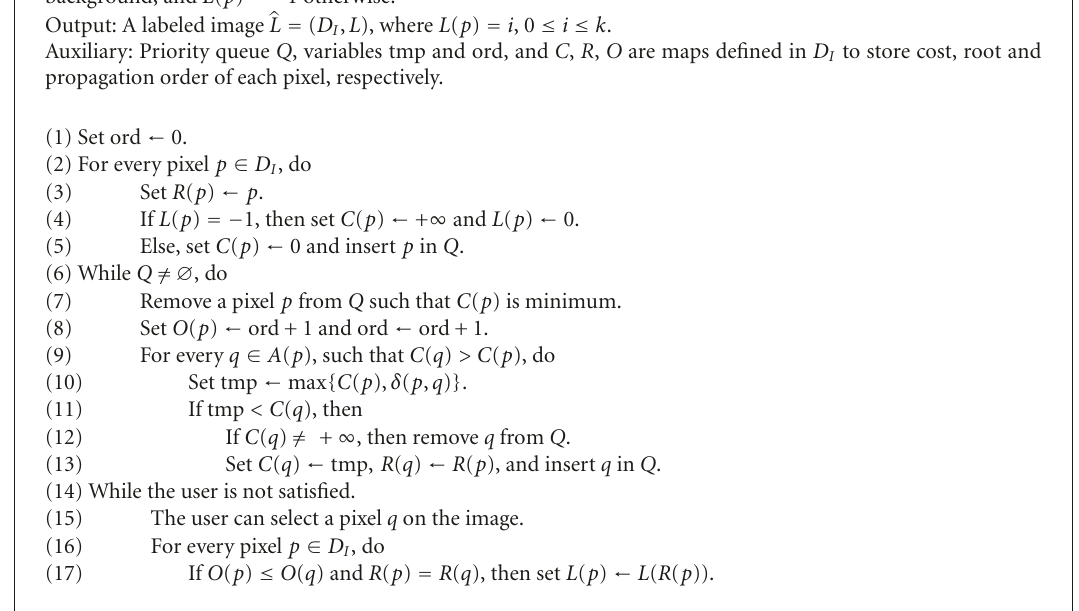
Algorithm 4: Multiple object definition with seed competition.